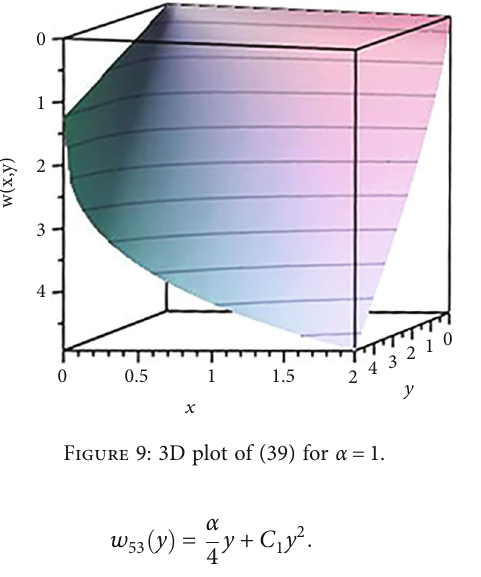
Figure 10: Plot of (43) for α = 1, 10